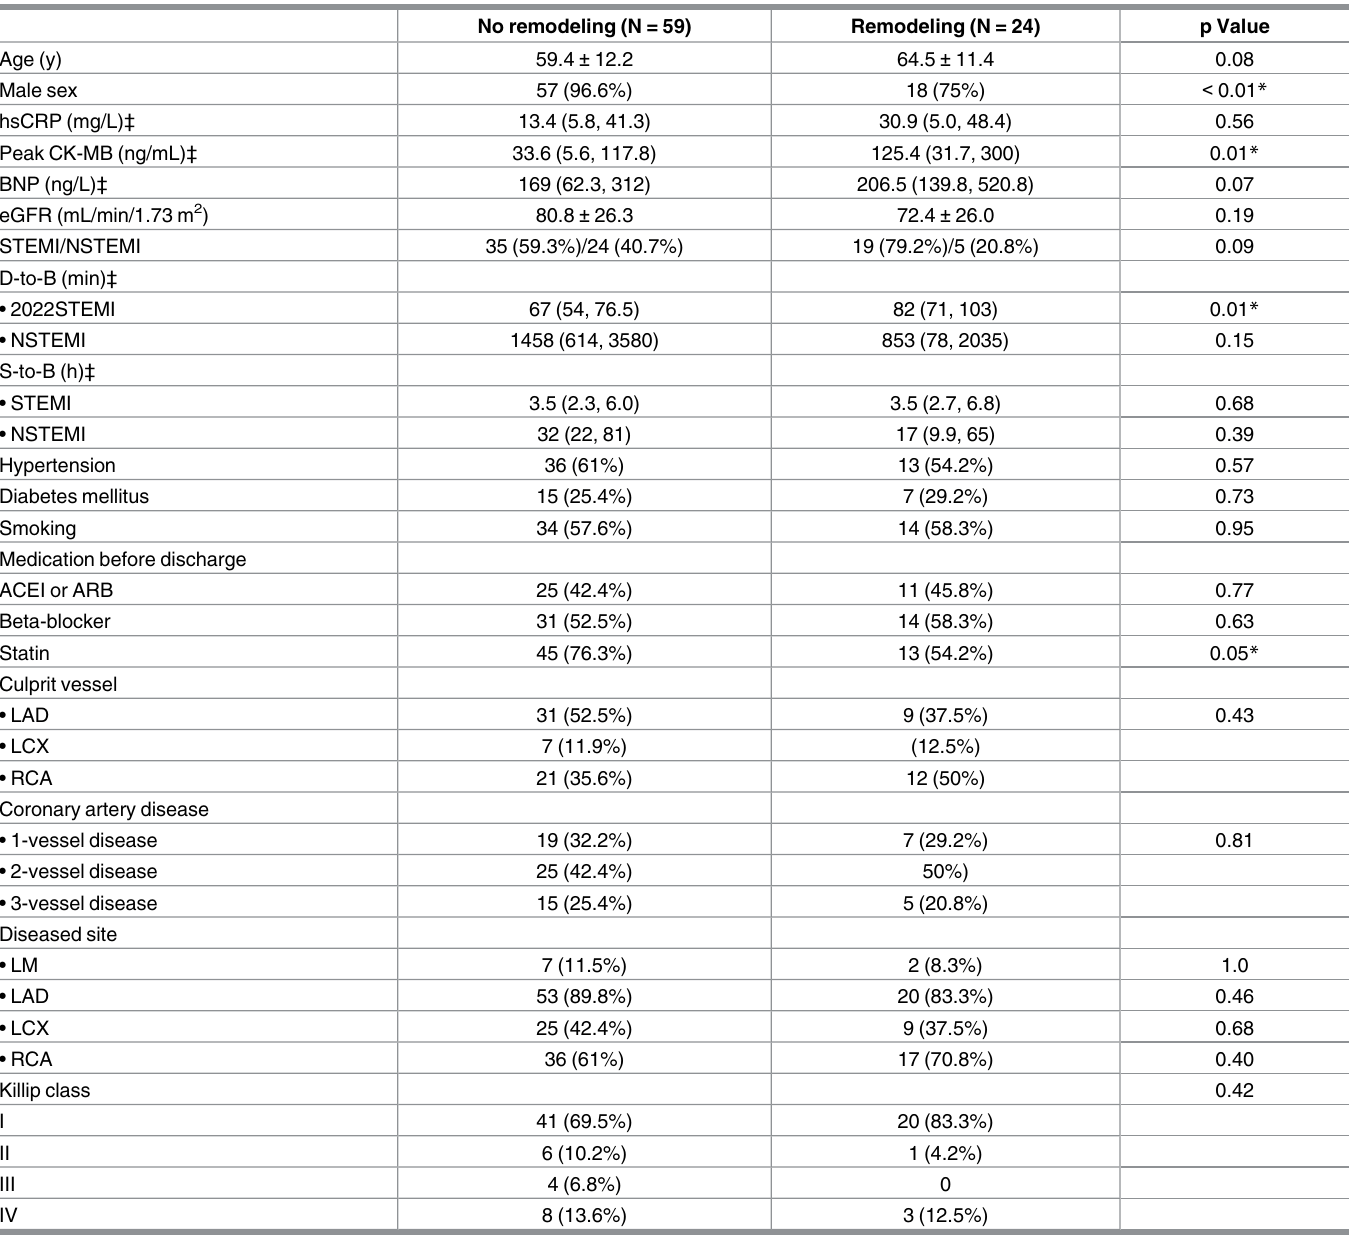
Table 1. Patients’ clinical